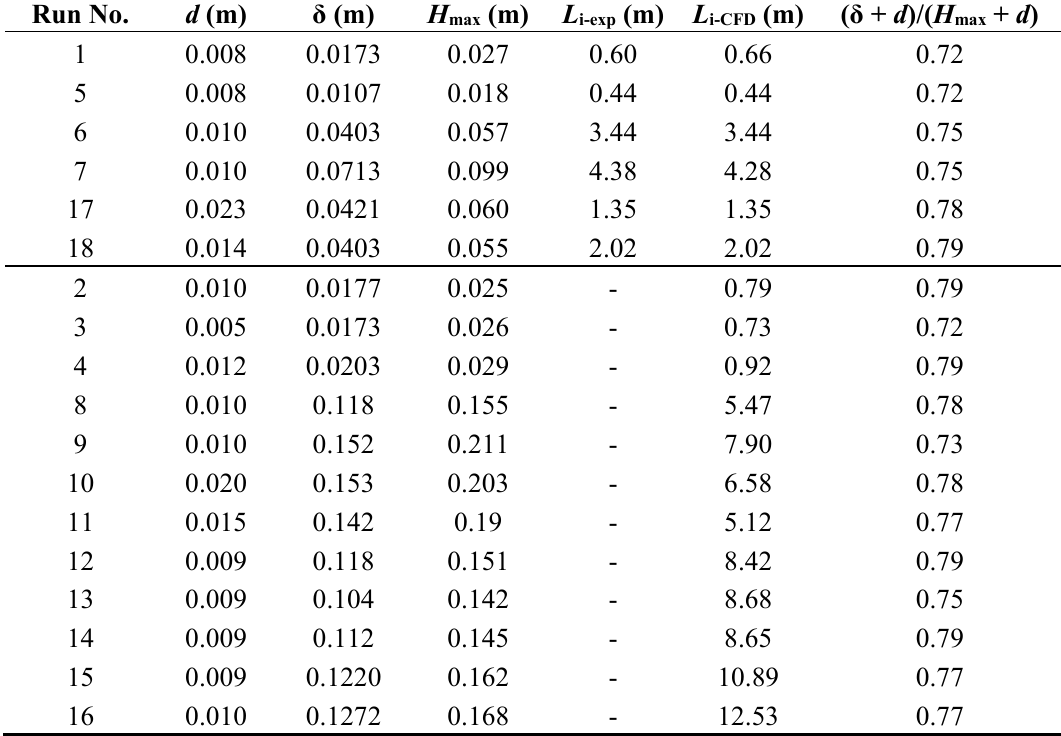
Table 3. Summary of the information of velocity profiles at inception